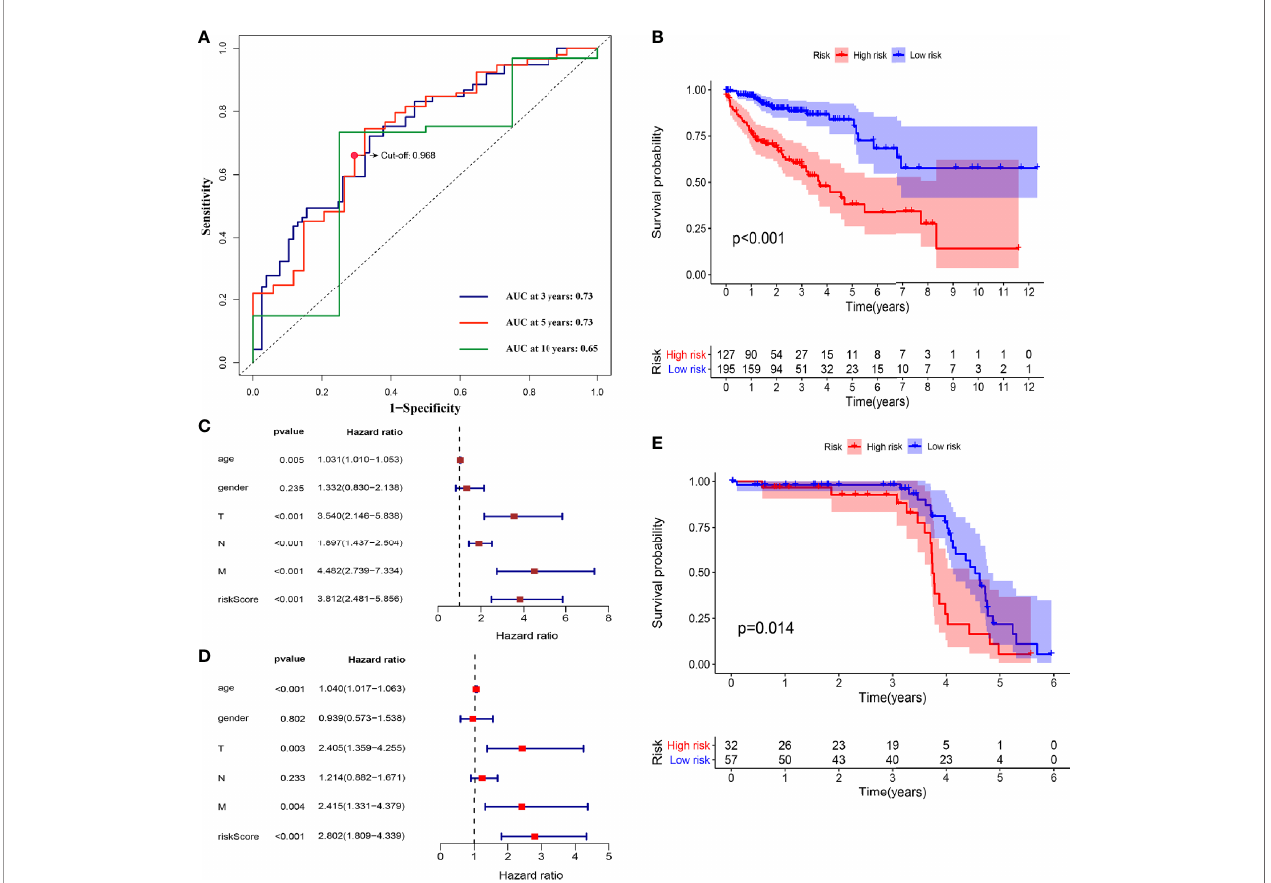
FIGURE 3 | (A) TimeROC curves for 3, 5, 10 years were plotted in the model group. The best cutoff value was marked on the 5-year TimeROC curve. (B) Kaplan- Meier curve of overall survival in model group. (C) Univariate-Cox regression analyze of prognostic factors in model group. (D) Multivariate-Cox regression analyze of prognostic factors in model group. (E) Kaplan-Meier curve of overall survival in validation